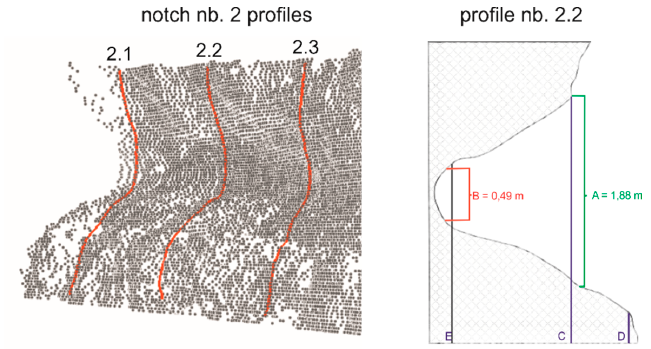
Figure 5. Example of a three-dimensional (3D) point cloud with derived cliff profile ( left ), and schema of the notch parameter estimation derived from its geometry ( right ). A—notch height, B—height of the retreating zone, C and D—maximum and minimum notch depth points, E—upper limit of the retreating zone depth. For notch location see Figure